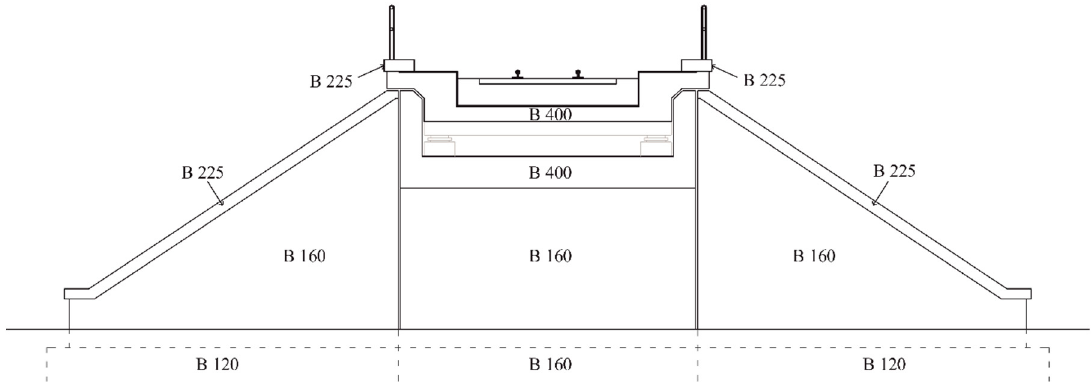
Figure 3. Cross-section of the Weikendorf Bridge with assigned concrete classes according to [57].